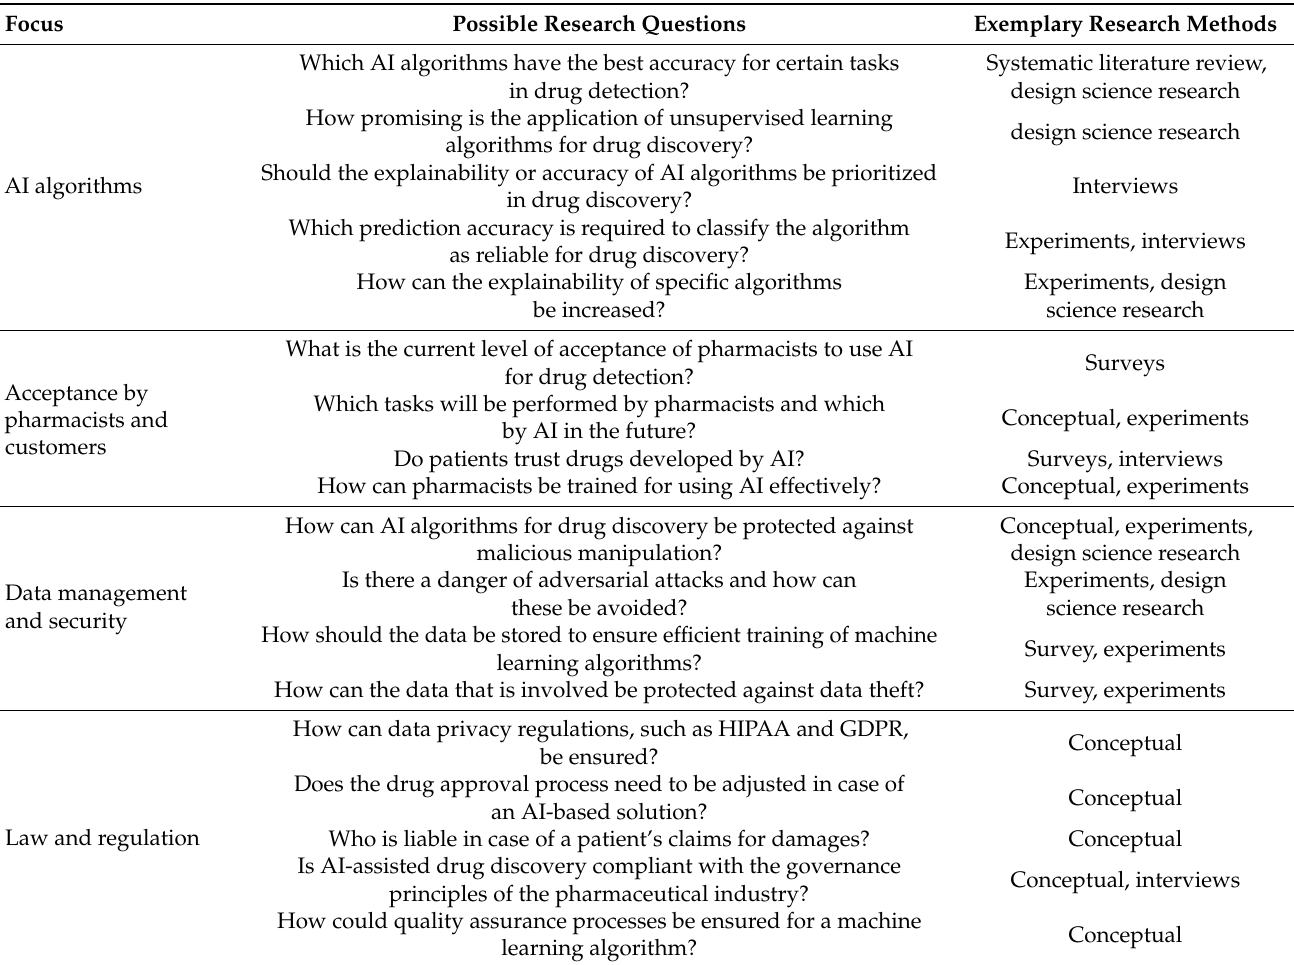
Table 10. Open research